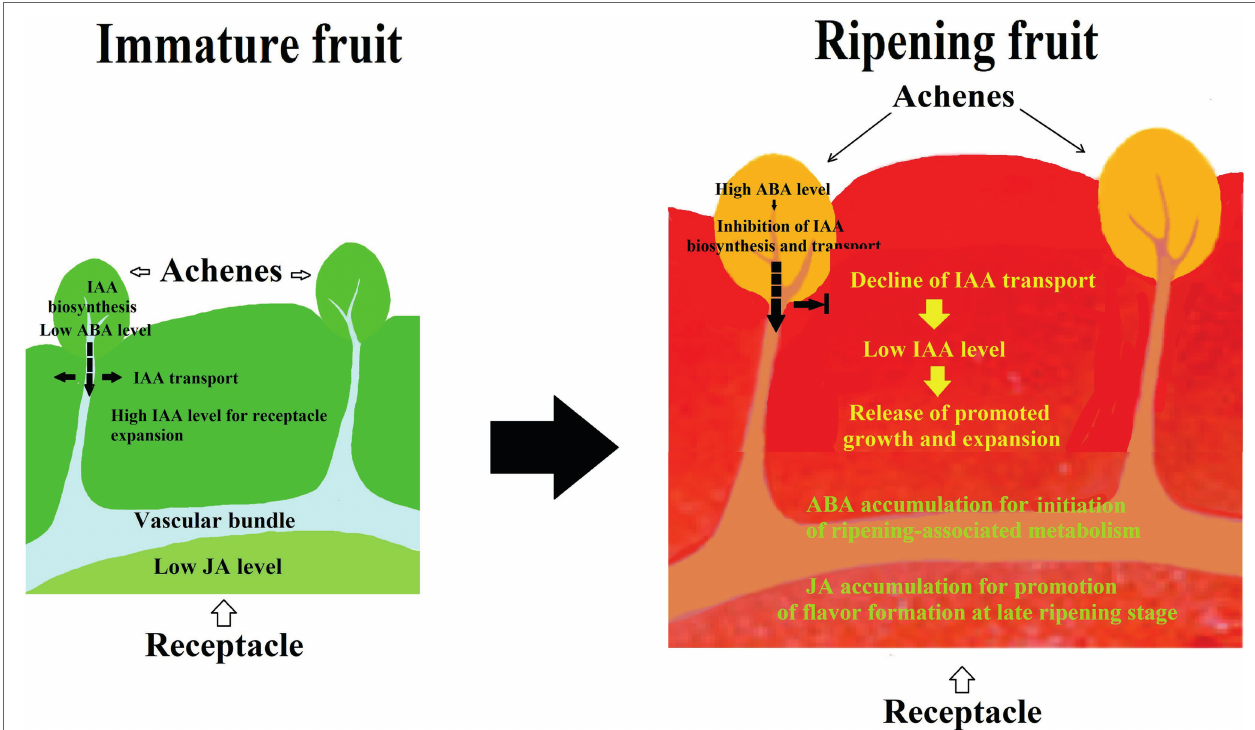
FIGURE 2 | Diagram showing the pattern of hormonal regulation of strawberry fruit ripening. IAA is synthesized in achenes and then transported to the receptacle, whereby promoting receptacle growth and suppressing fruit ripening. Along with fruit development and ripening, ABA accumulates in both achenes and receptacle. ABA accumulation in the achenes acts to suppress the IAA biosynthesis and transport to the receptacle, resulting in a decrease in the IAA level of the receptacle and release of the ripening inhibition. ABA accumulation in the receptacle acts to initiate ripening-associated metabolisms, and JA accumulation may likely act to regulate the ripening-associated events at a later ripening stage. As such, strawberry fruit ripening is regulated by a synergistic action of multiple